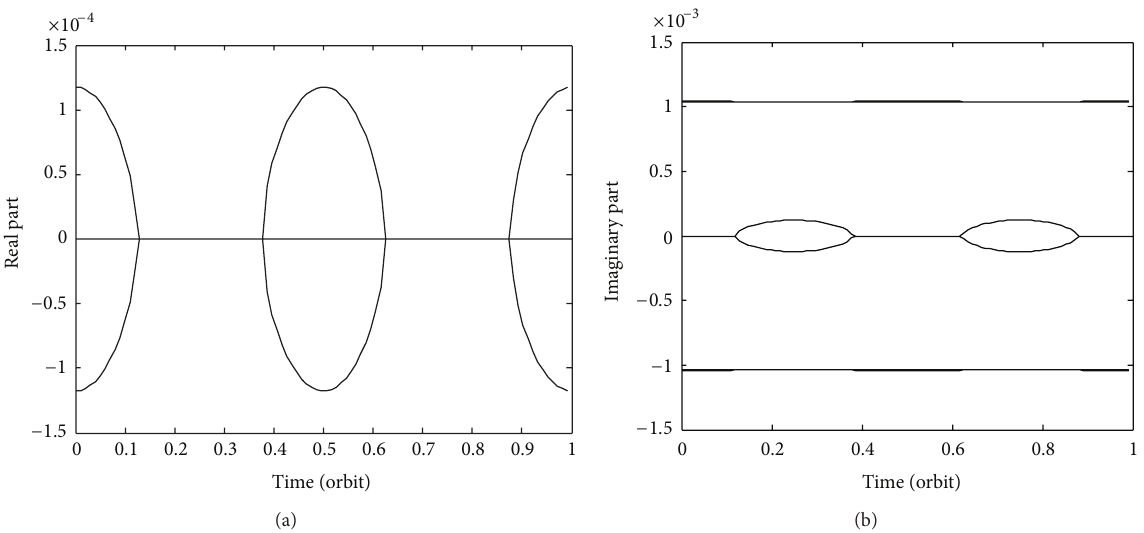
Figure 6: Topological type of the uncontrolled equilibrium: (a) the time history of real part of the equilibrium during the orbital period; (b) the time history of imaginary part of the equilibrium during the orbital